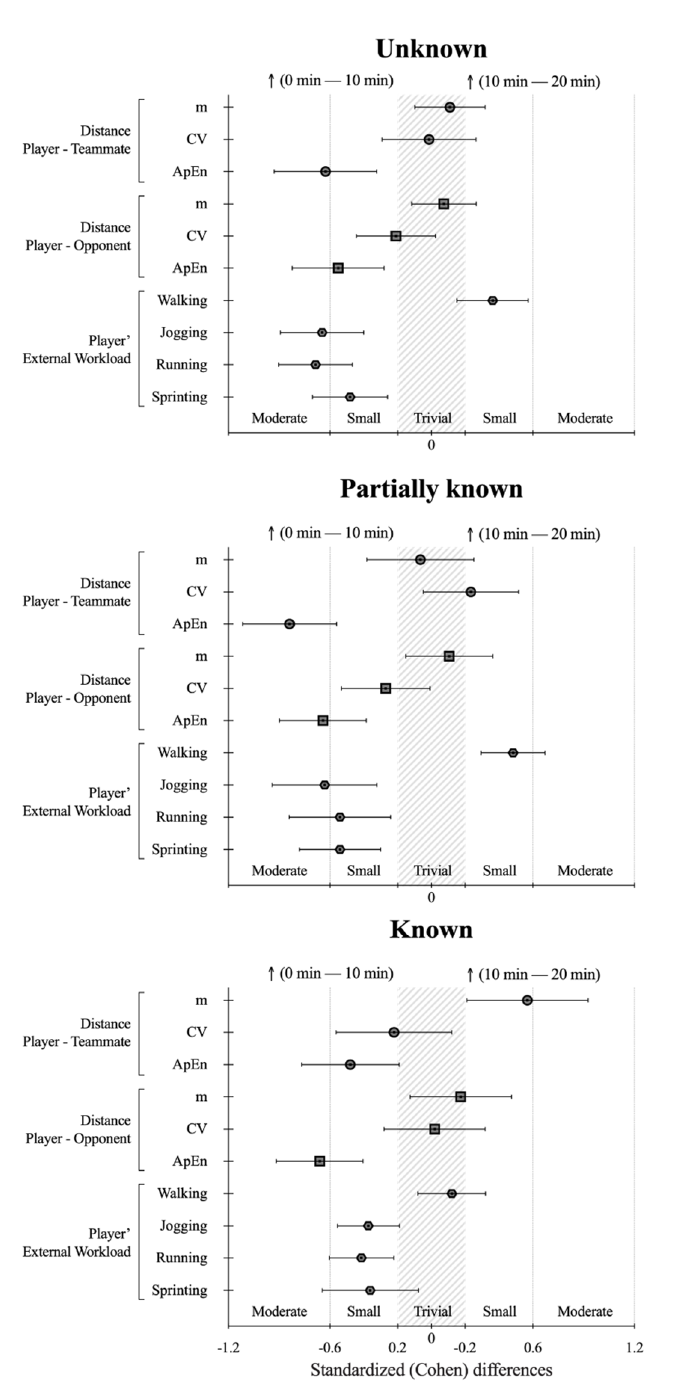
Figure 1. Standardized Cohen’s differences for comparative results of the (0 min–10 min) vs. (10 min–20 min) in the different condition game variables. Error bars indicate uncertainty in true mean changes with 90% confidence intervals. Abbreviations: m = meters; CV = coefficient of variation; ApEn = approximate entropy.